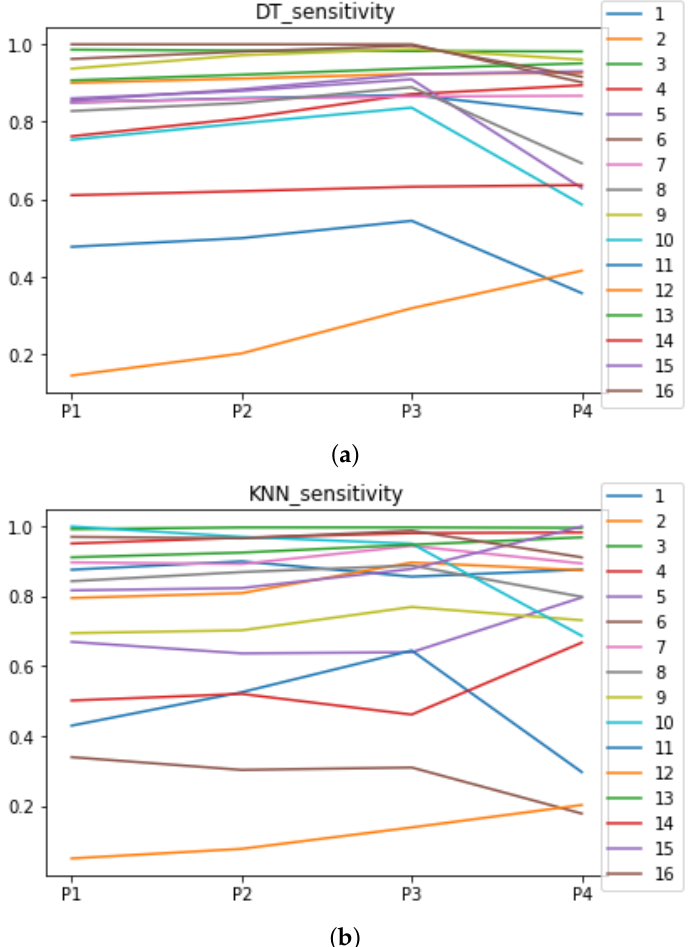
Figure A4. Behavior RHOASo: sensitivity. The datasets are represented with a bar chart for each partition. ( a ) Sensitivity for DT. ( b ) Sensitivity for